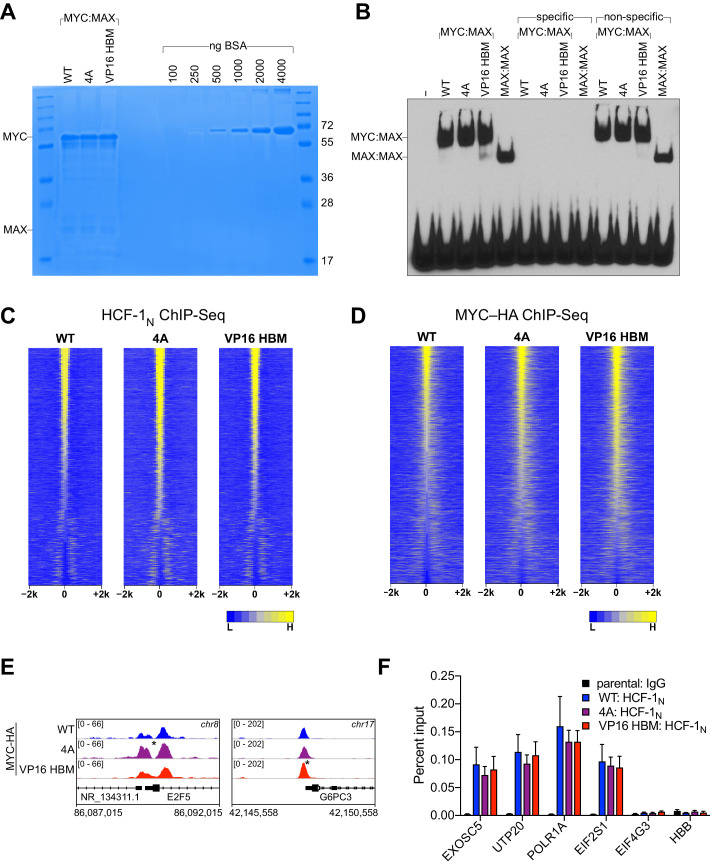
Impact of host cell factor (HCF)–1-binding motif (HBM) mutations on MYC and HCF-1 binding to chromatin.(A) Recombinant MYC (wild-type [WT], 4A, or VP16 HBM):MAX dimers used in these assays. Dimers were separated by SDS-PAGE alongside a BSA standard and stained using Coomassie Brilliant Blue. (B) Electrophoretic mobility shift assay (EMSA) using recombinant MYC:MAX and MAX:MAX dimers incubated with a biotinylated E-box probe (5′-GCTCAGGGACCACGTGGTCGGGGATC-3′). Binding reactions were conducted with or without 100-fold excess of unlabeled specific (as above) or nonspecific (5′-GCTCAGGGACCAGCTGGTCGGGGATC-3′) competitors. (C and D) Heatmap of the combined average normalized peak intensity in 100 bp bins for all HCF-1N (C) or MYC-HA (D) ChIP-Seq peaks that were within ±2 kb of a TSS, and scaled across each of the cell lines. For clarity in (D), some low-signal data points are excluded. (E) Example IGV screenshots of regions that had significant changes for MYC-HA by ChIP-seq. Asterisks mark the peaks that were significantly changed compared to WT. (F) ChIP, using anti-HCF-1N antibody, was performed on parental or switchable Ramos cells treated for 24 hr with 20 nM 4-OHT. Enrichment of genomic DNA was monitored by qPCR using primers that amplify across peaks. EIF4G3 and HBB are negative loci for HCF-1N. ChIP efficiency was measured based on the percent recovery from input DNA. Shown are the mean and standard error for three biological replicates.